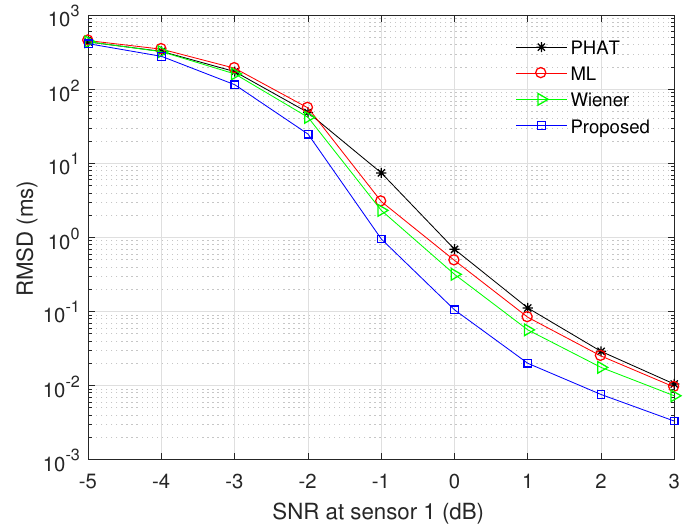
Figure 5. Root mean square deviation (RMSD) of time difference error for various prefilters, when α = 0.5, N = 4096, and M = 30.